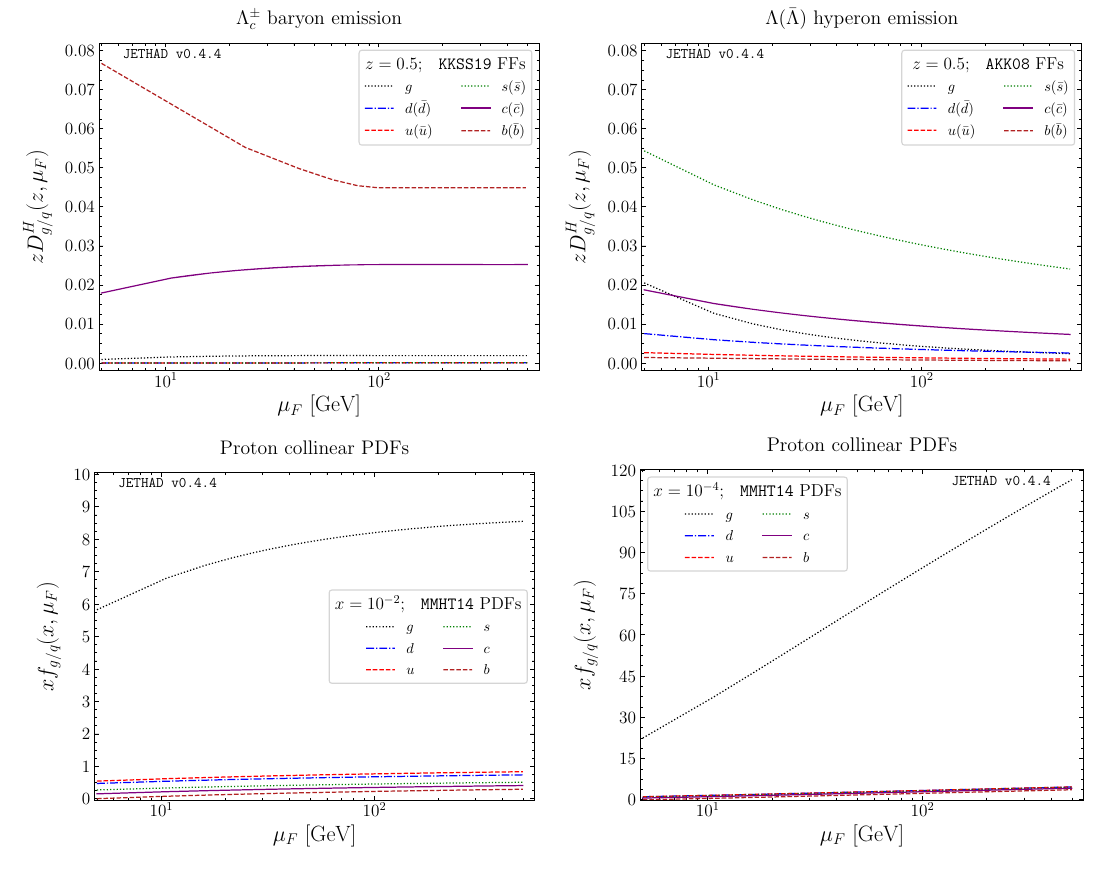
Fig. 8 Upper panels: energy-scale dependence of (cid:2) ± c KKSS19 (left) and (cid:2)( ¯ (cid:2)) AKK08 (right) NLO FFs for z = 5 × 10 − 1 (left). Lower panels: energy-scale dependence of MMHT14 NLO gluon and quark PDFs for x = 10 − 2 (left) and x = 10 − 4 (right)